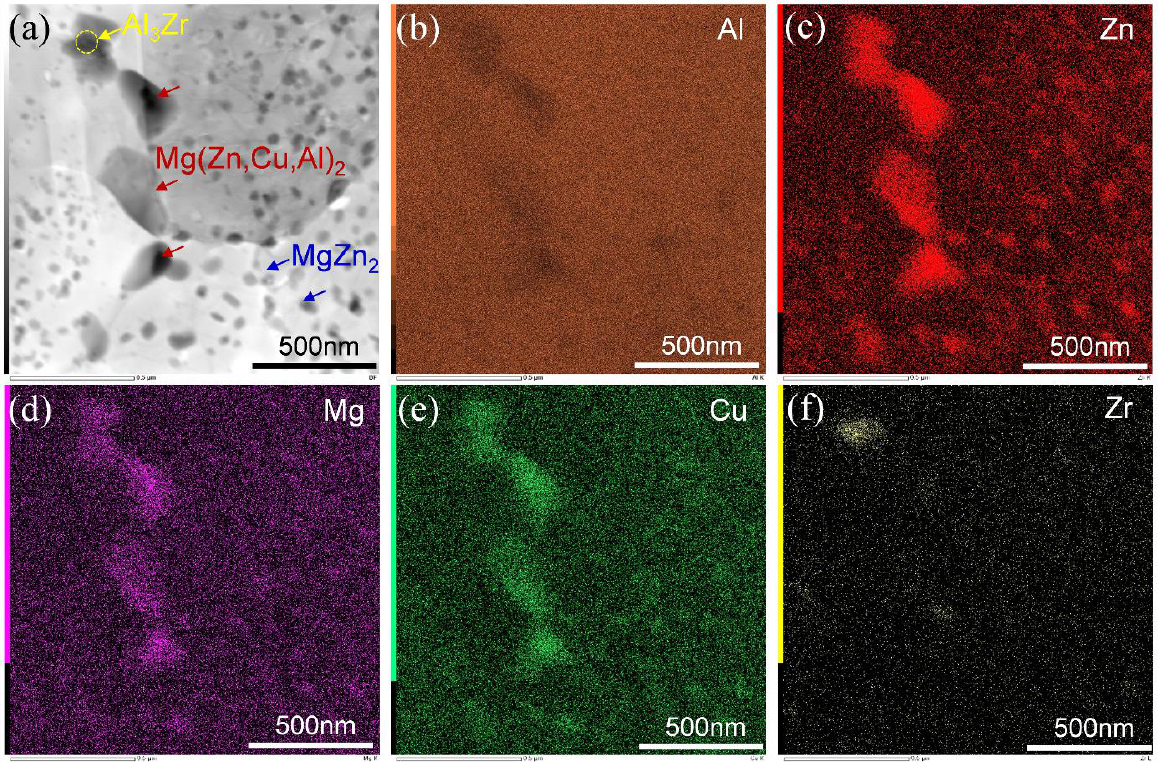
Figure 5. STEM image and nanoscale EDS mapping of Al, Zn, Mg, Cu, and Zr: ( a ) STEM image; ( b ) distribution of Al; ( c ) distribution of Zn; ( d ) distribution of Mg; ( e ) distribution of Cu; ( f ) distribution of Zr.